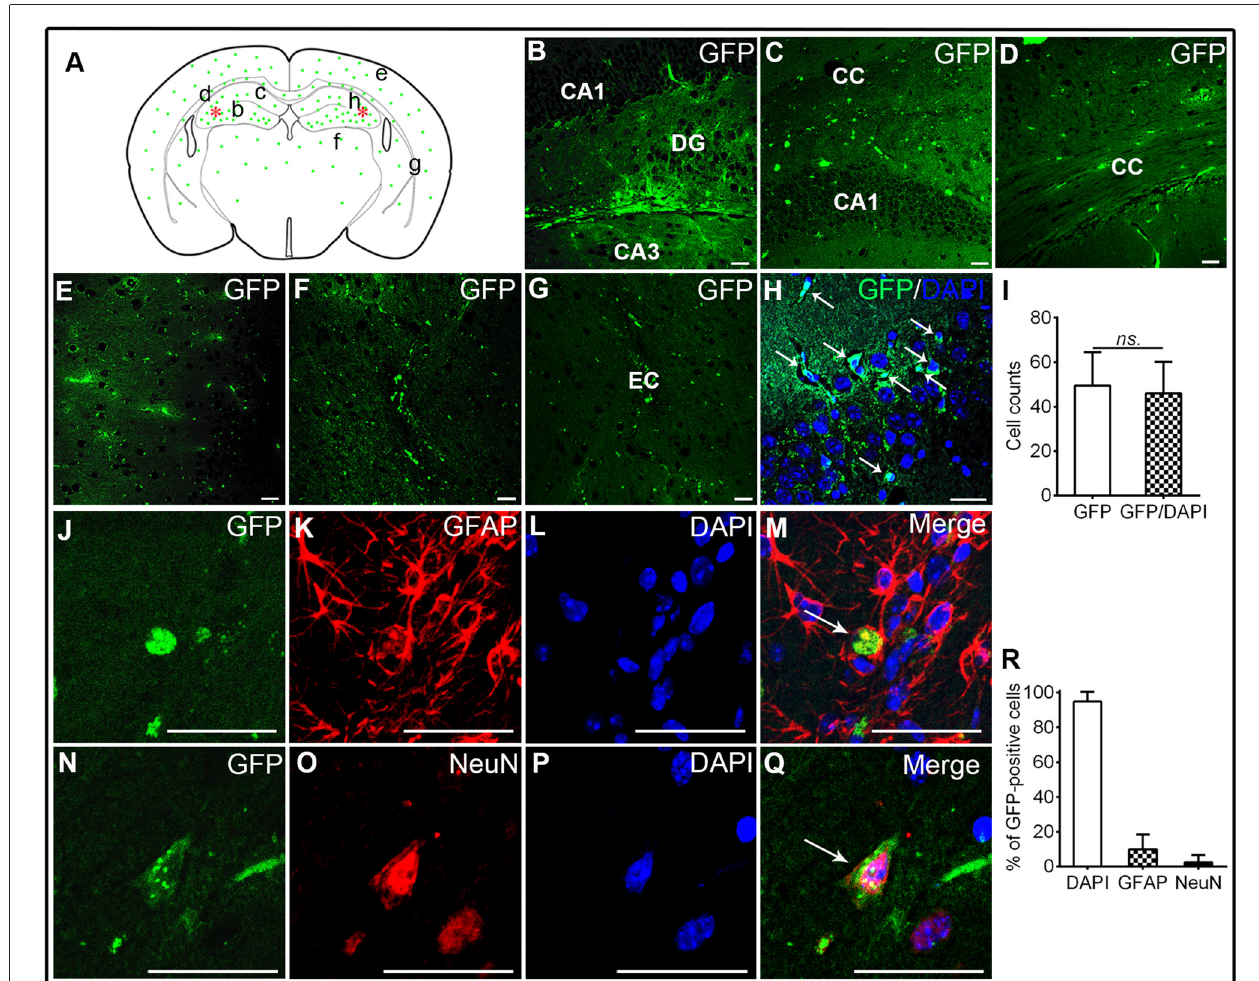
FIGURE 1 | Transplantation of human brain-derived neural stem cells (hNSCs) into hippocampal CA1 region of amyloid precursor protein (APP)/presenilin 1 (PS1; Alzheimer’s disease, AD) mice. (A) Schematic drawing of a typical coronal brain section, illustrating the distribution of engrafted green fluorescent protein (GFP)-labeled cells (green dots). Asterisks represent the transplantation sites. Lowercase letters indicate sites where corresponding images (B–G) were taken. (B,C) Transplanted hNSCs engrafted into the hippocampus, and they migrated extensively into corpus callosum (D) , frontal cortex (E) , thalamus (F) and external capsule (G) . (H,I) GFP-labeled hNSCs co-localized well with 4 (cid:48) ,6-diamidino-2-phenylindole (DAPI; white arrow). Some of hNSCs differentiated into GFAP-astrocytes or mature neurons (J–R) . There was no significant difference in counts between GFP-labeled and GFP/DAPI co-labeled cells ( ns. = p > 0.05). Scale bar: 50 µ